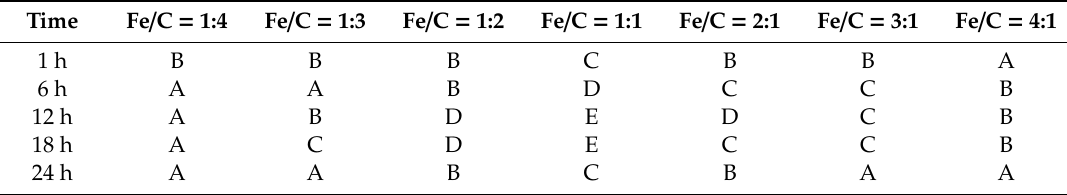
Table 4. Significance analysis of variance of Fe/C ratio.